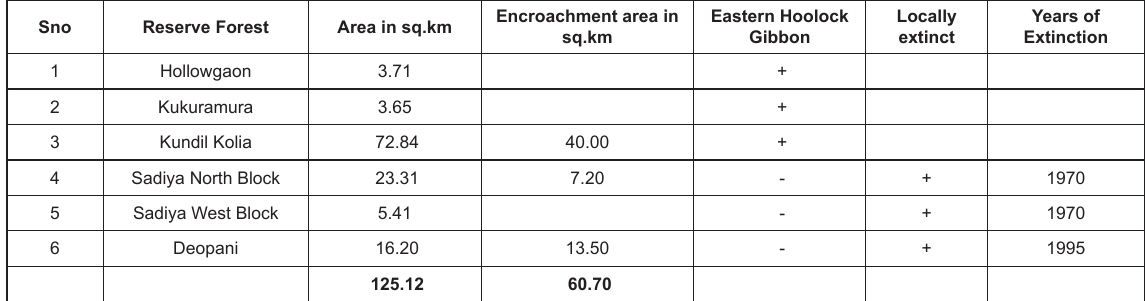
Table 3. Reserve forest, encroachment and extinction Sno Reserve Forest Area in sq.km